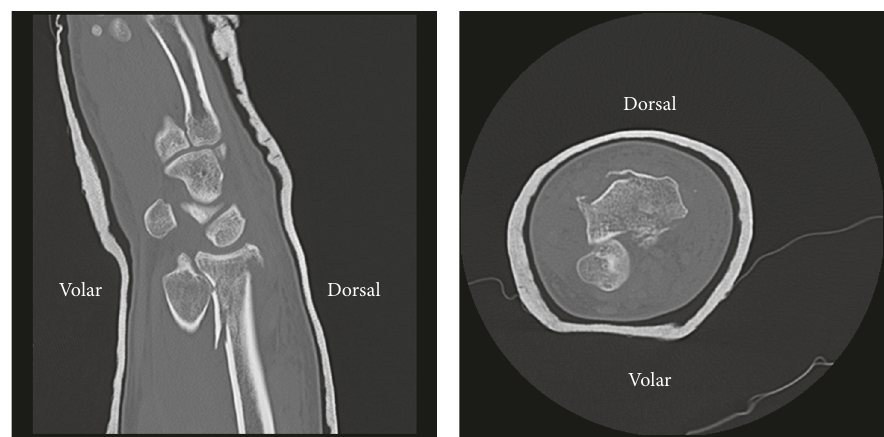
Figure 2: Sagittal and coronal computed tomography views showing the volar DRUJ dislocation.